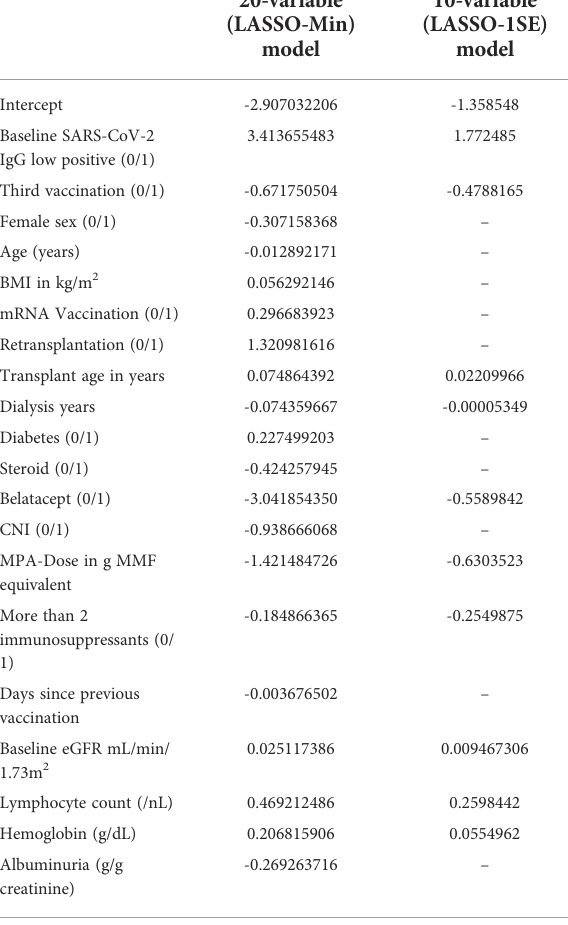
TABLE 5 Final intercept and coef fi cients of the 20-variable (LASSO- Min), and 10-variable (LASSO-1SE) logistic regression model fi tted on the entire development dataset, both of which are used for external